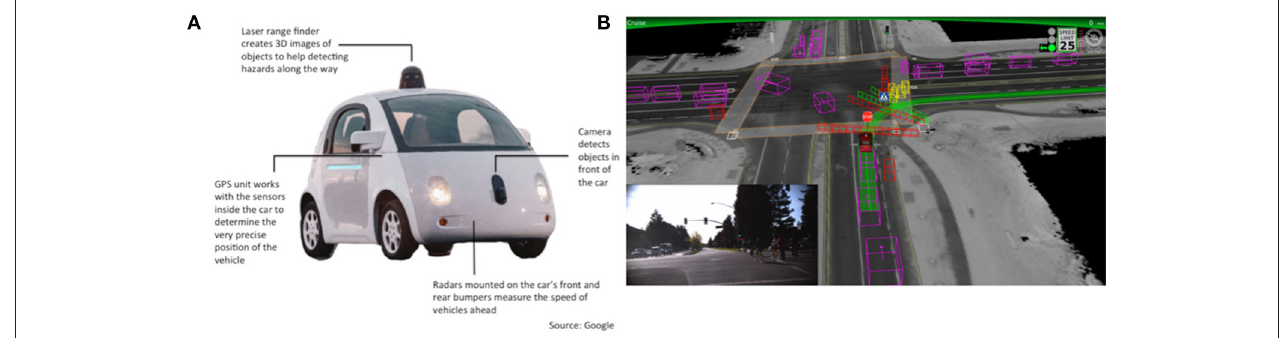
FIGURE 2 | Examples of enabling technologies. (A) Sensors of a self-driving car (source: Google). (B) Schematic of how objects are represented (from the self-guiding car’s perspective) while approaching a turn; the inset shows what a human driver sees from inside the car. This representation can be used to generate predictions (e.g., of the trajectory of cars and pedestrians) based, for example, on probabilistic mechanisms (Thrun et al., 2006). that are likely to show the most critical information.